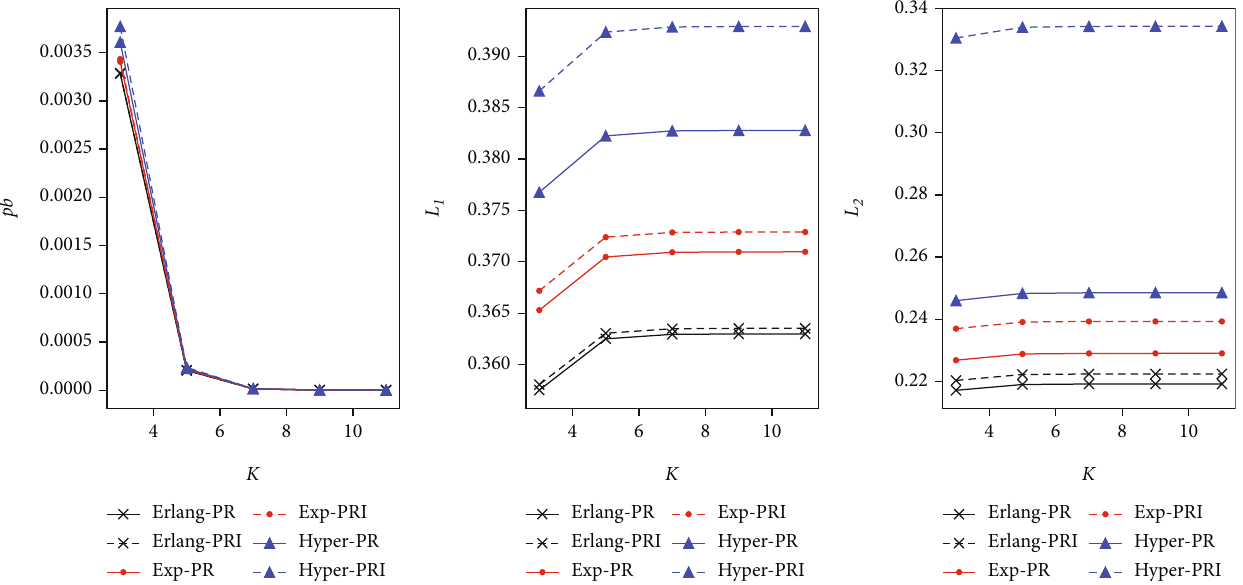
Figure 3: Performance measures for various values of K .